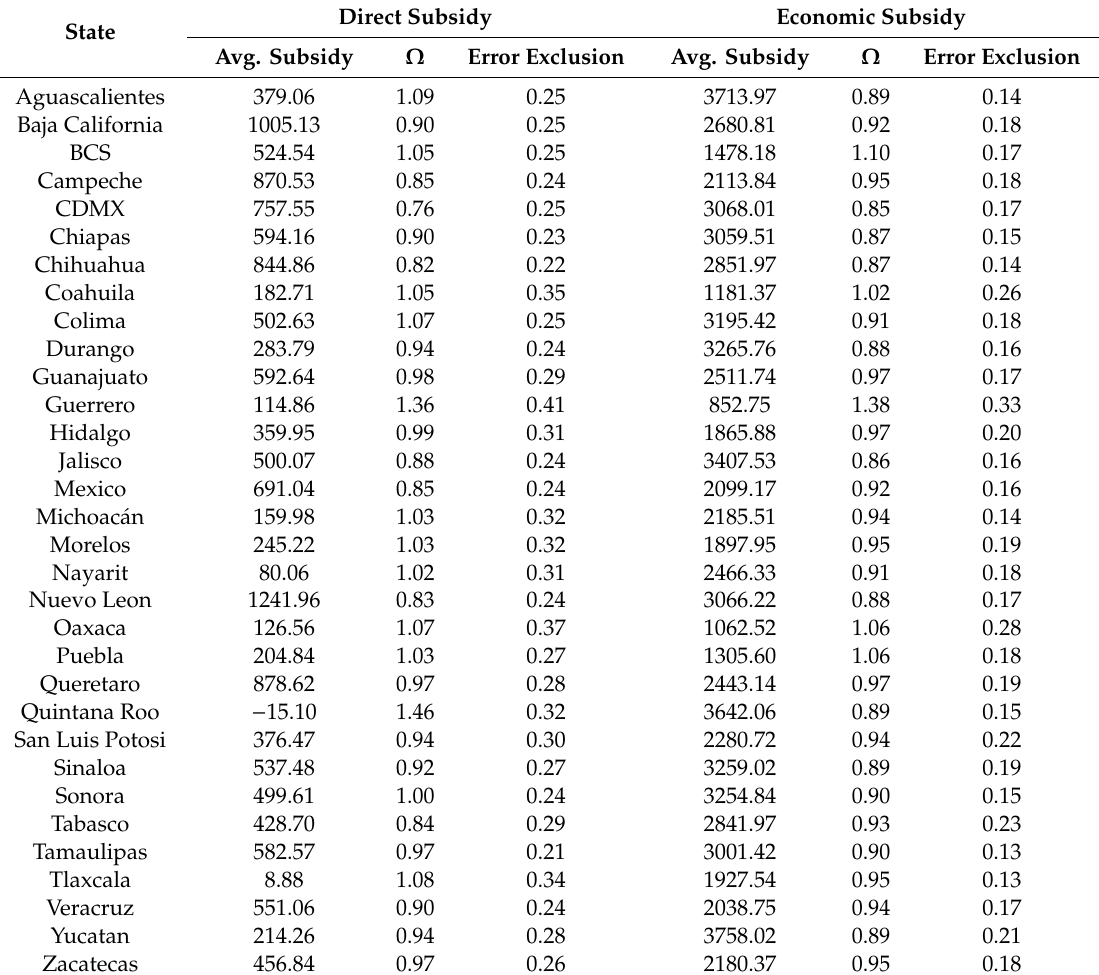
Table 7. Subsidy performance by